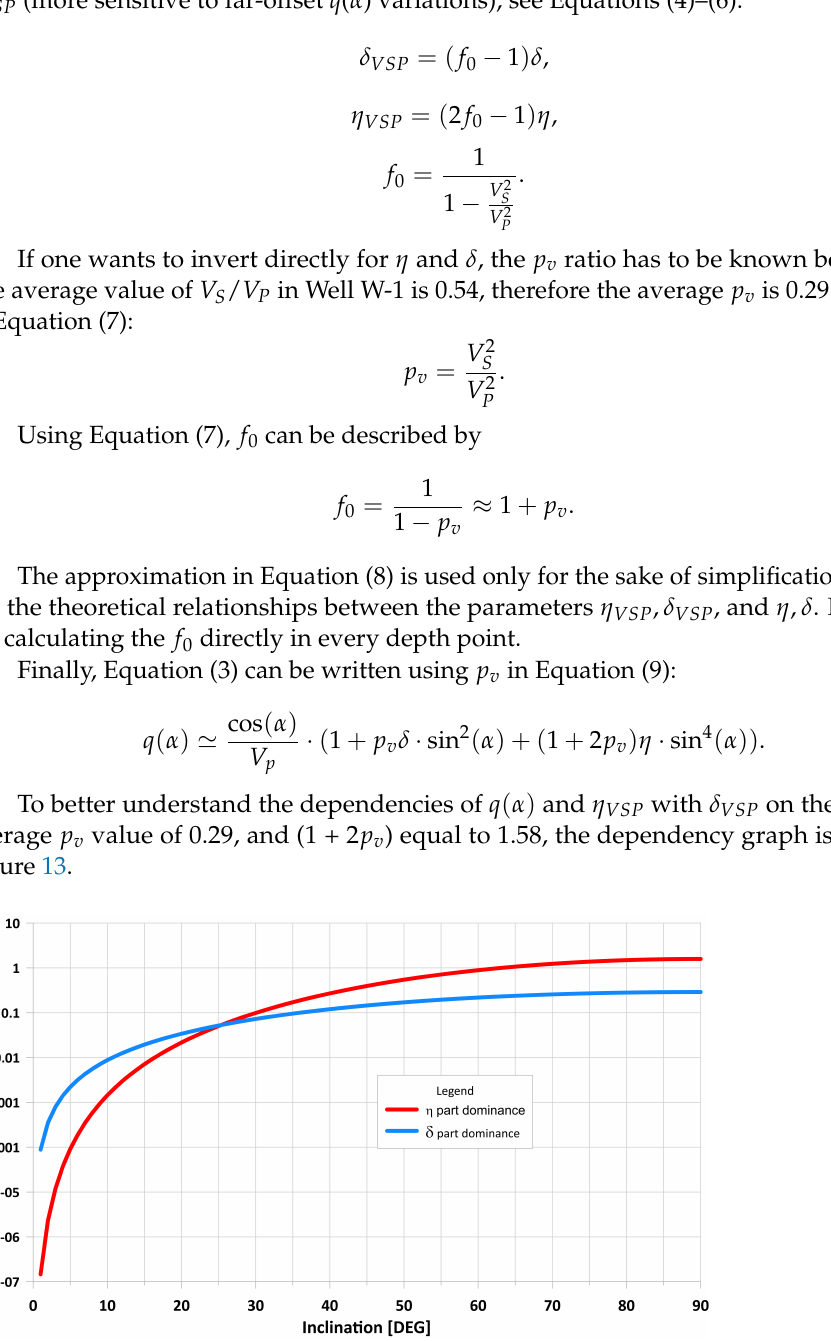
Figure 13. Anisotropic parameters of the offset dependence graph. Axis x shows inclination angles. The increase in the inclination angle is related to the increase in the